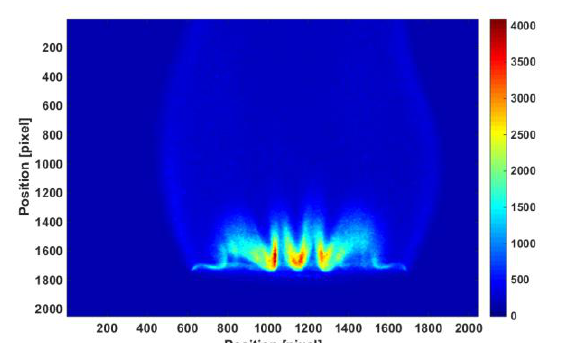
Fig. 9. C 10880-03, 25% gain, exposure time 20µs